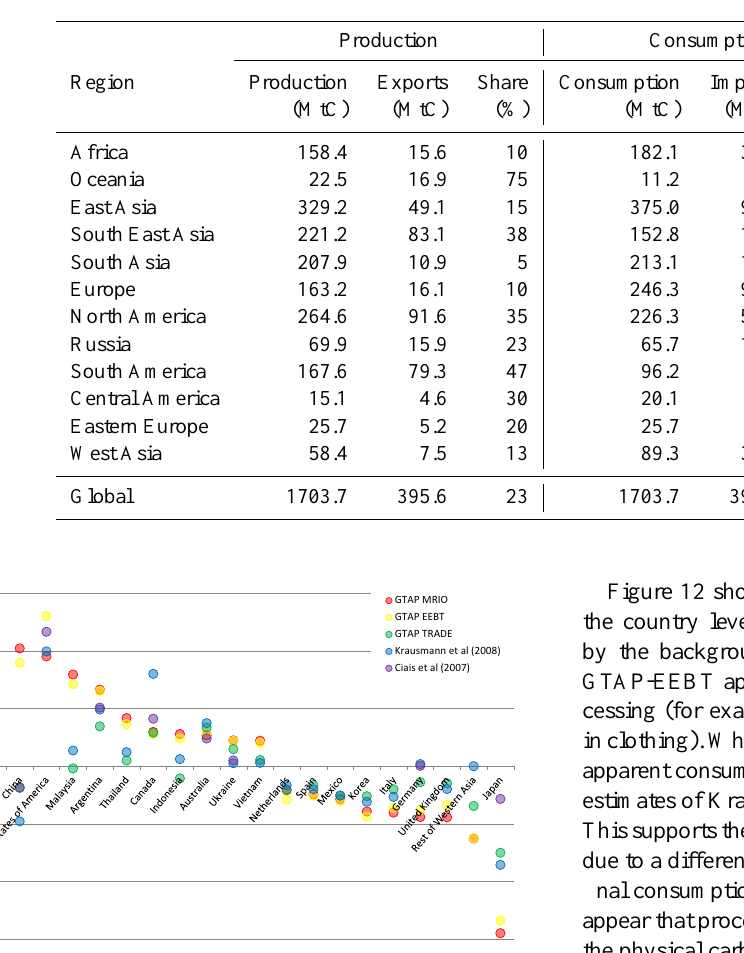
Table 11. The 2004 crops extracted in each region (production) in terms of carbon, the amount and share exported, the consumption amount and share imported, and the difference between production and consumption (and exports and imports). Exports and imports only represent the trade between the RECCAP regions, and do not include the trade between countries within a region (e.g. Finland and Sweden). The shares are always in terms of production.